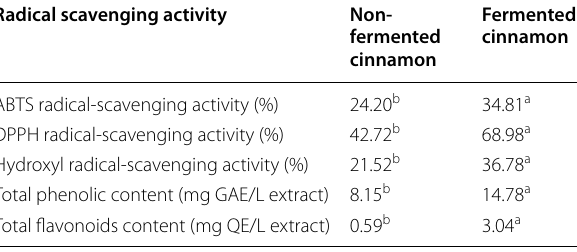
Where the data are the means of triplicate experiments; samples in the same row with different superscript letters are significantly different (P < 0.05). a value is the highest scavenging activity, and b value is the lowest scavenging activity in the same row